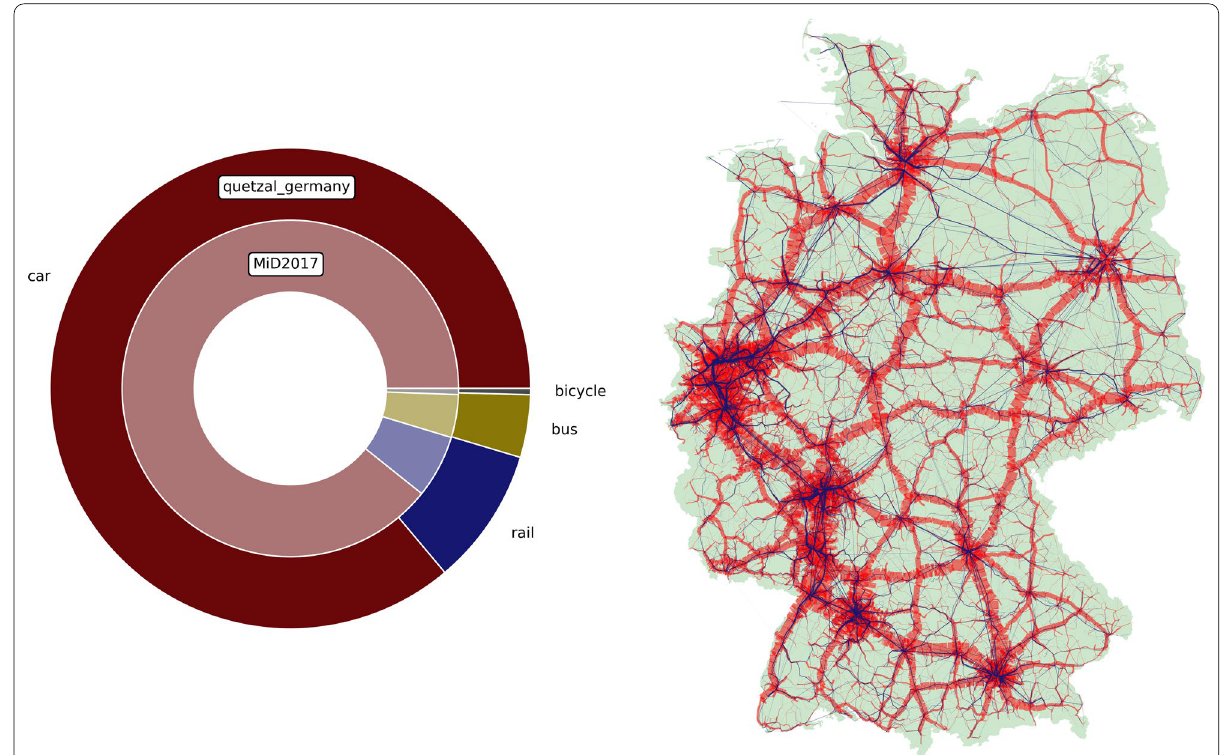
Fig. 3 Modal splits for inter-zonal travel without air transport (left) and traffic distribution of car (red) and public transport (blue)